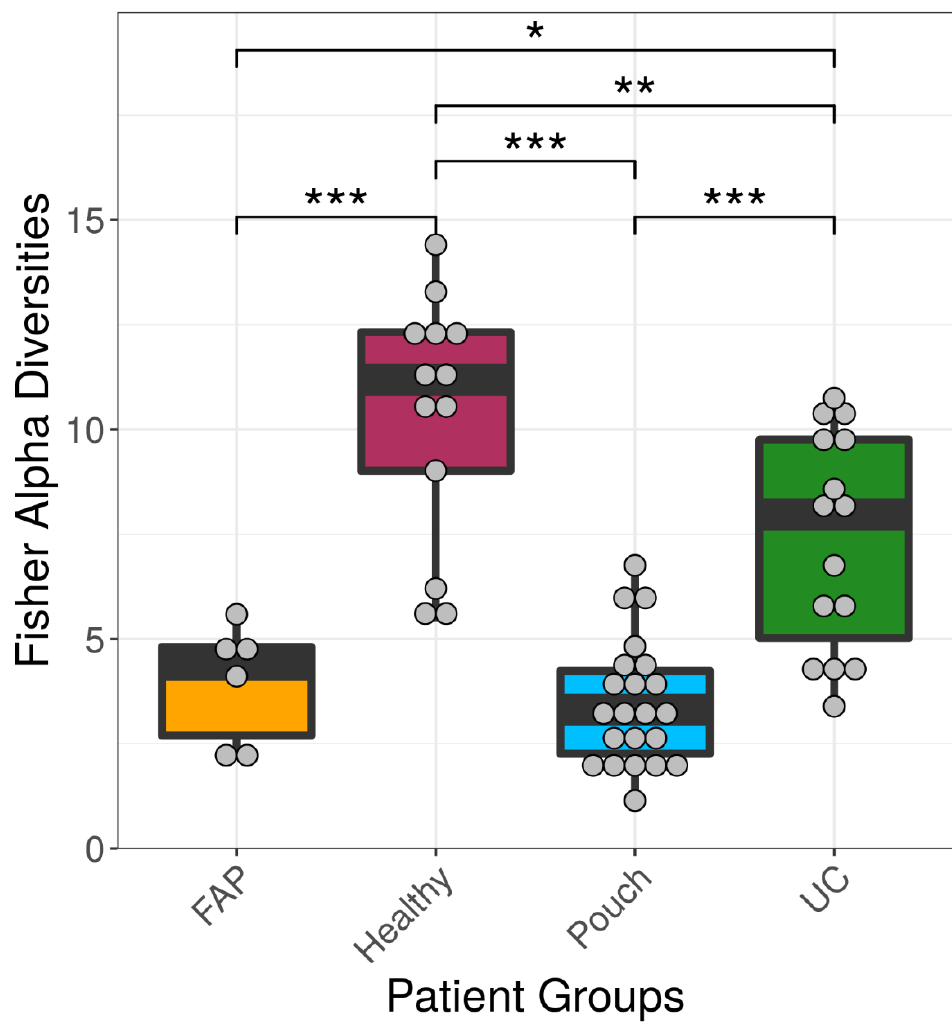
Figure 1. Alpha diversities of the main groups. Data represent Fisher alpha diversity indices at the OTU level based on 16S rRNA profiling of the V4 region. *** indicates significant differences from two-sided Wilcoxon rank sum test p = 3.4 × 10 − 6 , 0.0008 and 4.4 × 10 − 5 for Healthy versus Pouch, Healthy versus FAP, and Pouch versus UC groups, respectively; ** indicates significant differences from two-sided Wilcoxon rank sum test, p = 0.0053 for Healthy versus UC groups; * indicates significant difference from two-sided Wilcoxon rank sum test, p = 0.0195 for UC versus FAP groups; sample sizes were 6, 13, 22 and 15 for FAP, Healthy, Pouch and UC groups, respectively. Central horizontal bars represent median values. For details, see Table S2.